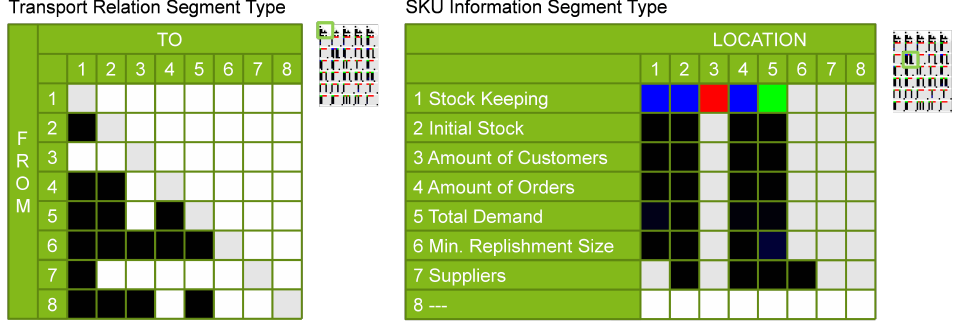
Figure 4. Graphical state representation (small image) and details of two exemplary image segments (large images)